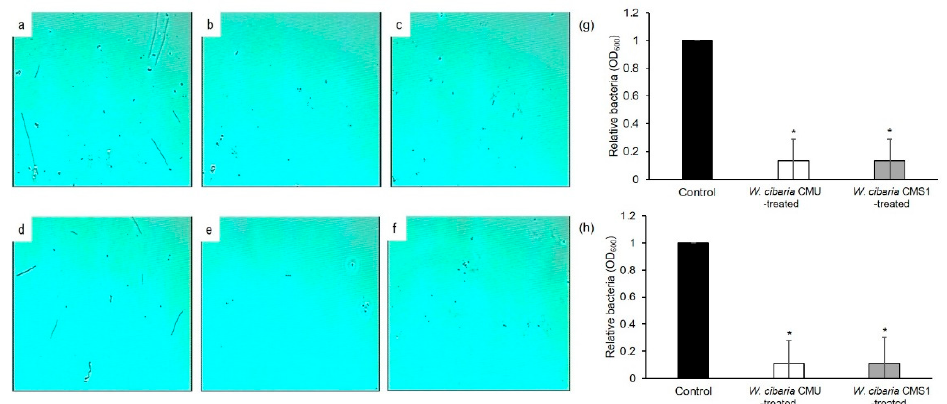
violet and measured at OD 595 . Black bar, control; white bar, W. cibaria CMU-treated; grey bar, W. cibaria CMS1-treated. Significant differences as compared to control determined as * p < 0.05, ** p ≤ 0.001.